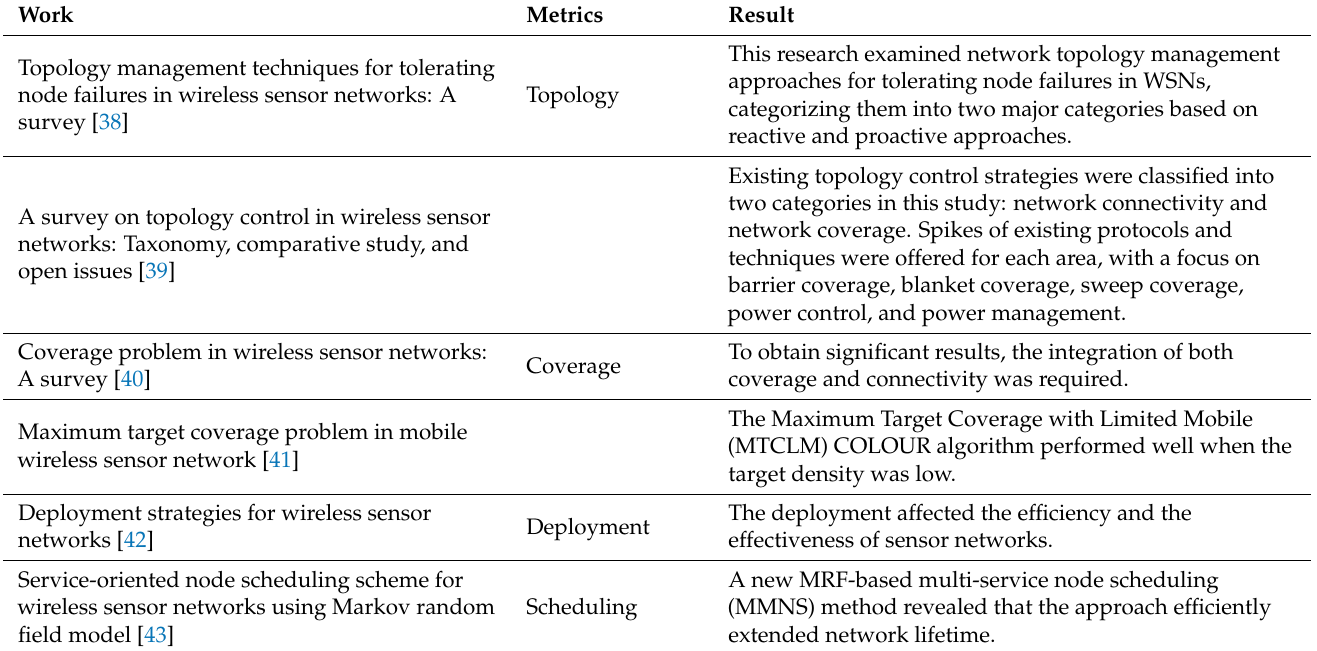
Table 2. Comparison of related work by metrics.